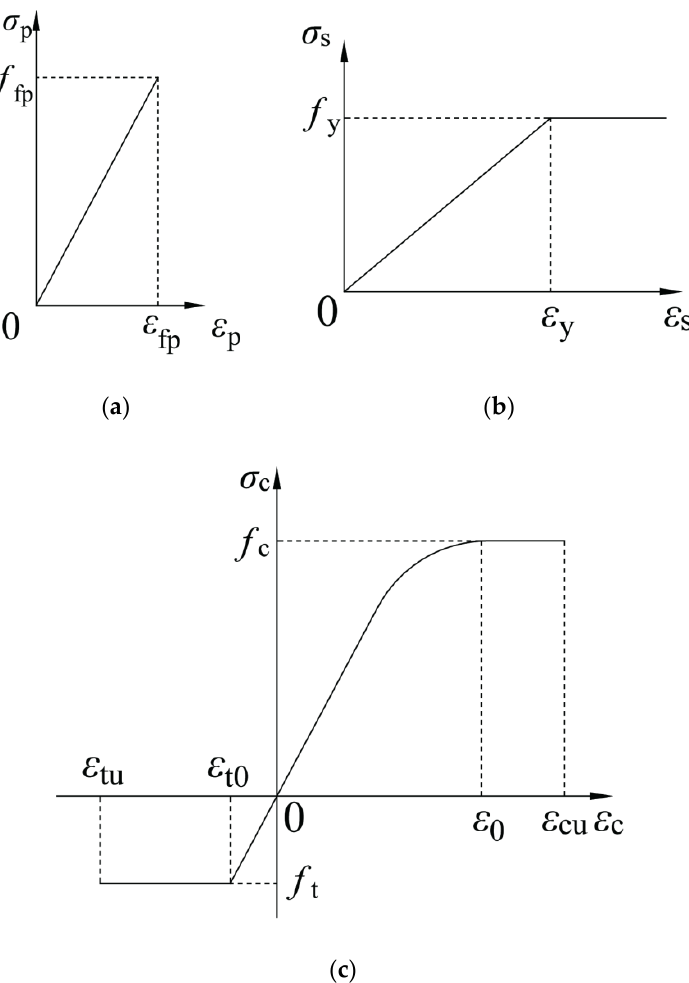
Figure 12. Stress – strain relationships of materials: ( a ) stress – strain relationship of CFRP; ( b ) stress – Figure 12. Stress–strain relationships of materials: ( a ) stress–strain relationship of CFRP; ( b ) stress– strain relationship of steel; ( c ) stress – strain relationship of UHPC. strain relationship of steel; ( c ) stress–strain relationship of